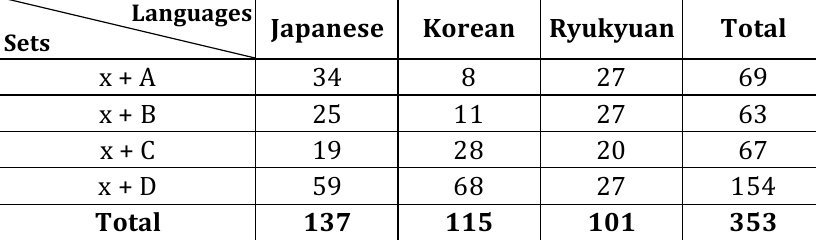
Table 12: Distribution of disyllabic nouns in the three historical sources (focusing on the second